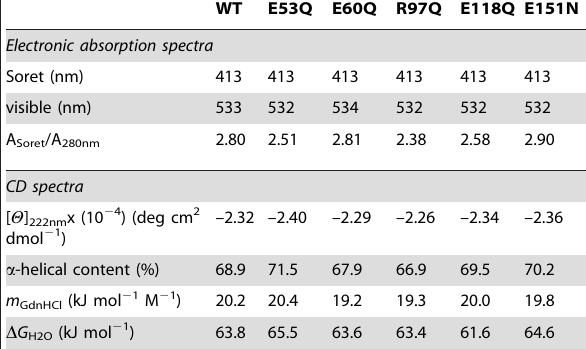
Table 1. Structural data of human ferric WT Ngb and Ngb mutants of crucial residues for protein-protein interaction between G a i1 and Ngb.